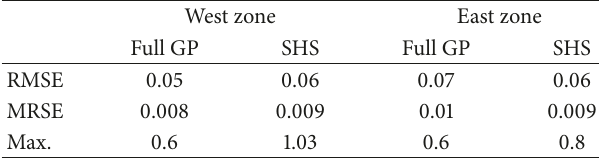
Table 2: Performance metrics for the prediction of the zone air temperature, with a comparison between the SHS model and the full GP